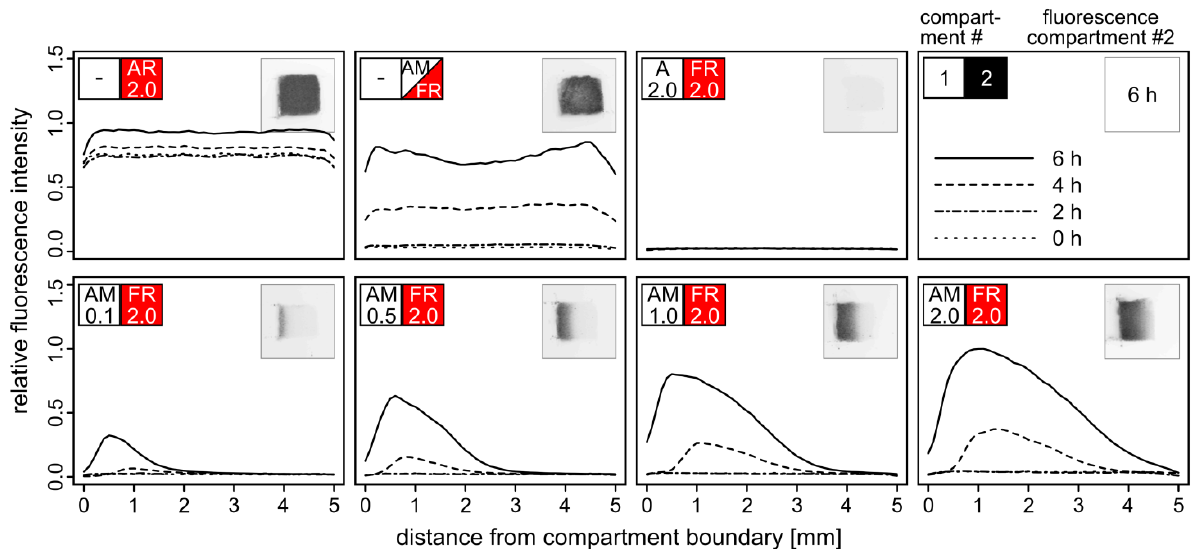
Figure 4. Induction of fluorescence by α–factor secreting cells in a 3D two-compartment amplifier system. Two adjacent compartments of 5 × 5 × 5 mm size in an agarose matrix were filled with plasmid-bearing BY4741 bar1 Δ cells with an optical density OD 0.1–2.0 (see Table 1 for identifiers). Red fluorescence of compartment 2 was detected after 0, 2, 4 and 6 h. Fluorescence scan images (small insets) and fluorescence intensity profiles (graphs) are shown. A value of 1.0 corresponds to the fluorescence intensity of a strain carrying plasmid p426ADH-TurboRFP (AR) after 6